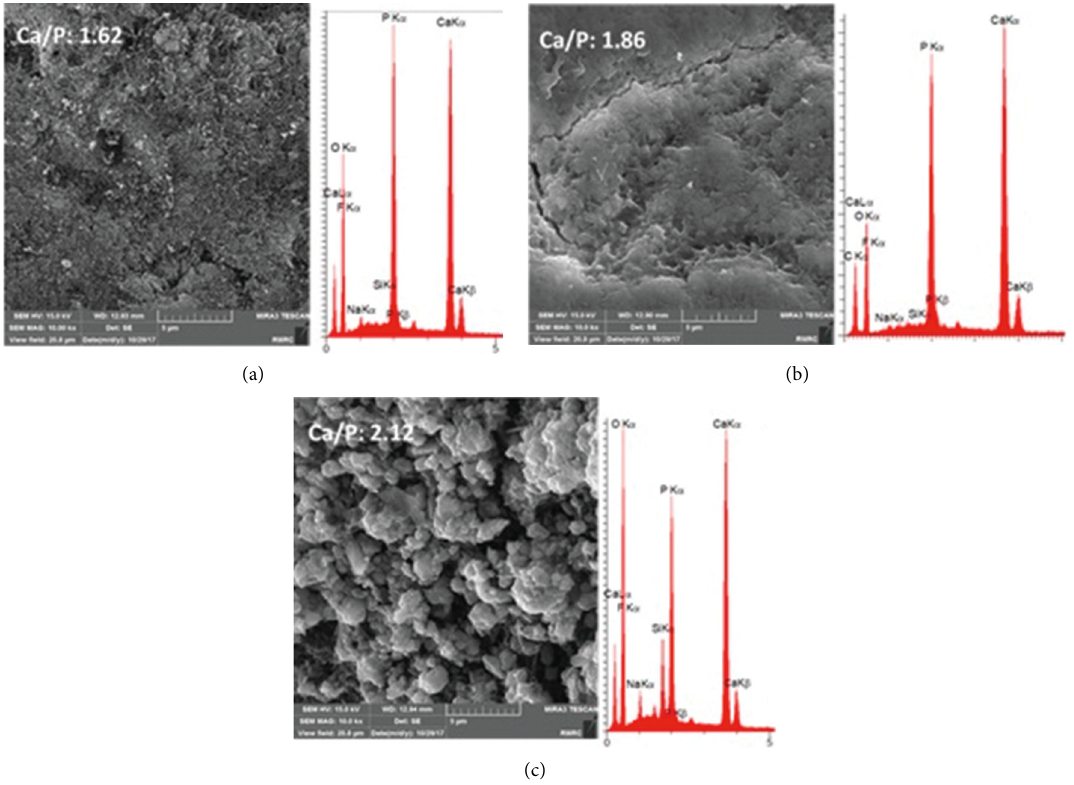
Figure 7: FESEM/EDS analyses of remineralized enamels by FluoroDose ® (a), GC Tooth Mousse (b), and 52S4/UPGO